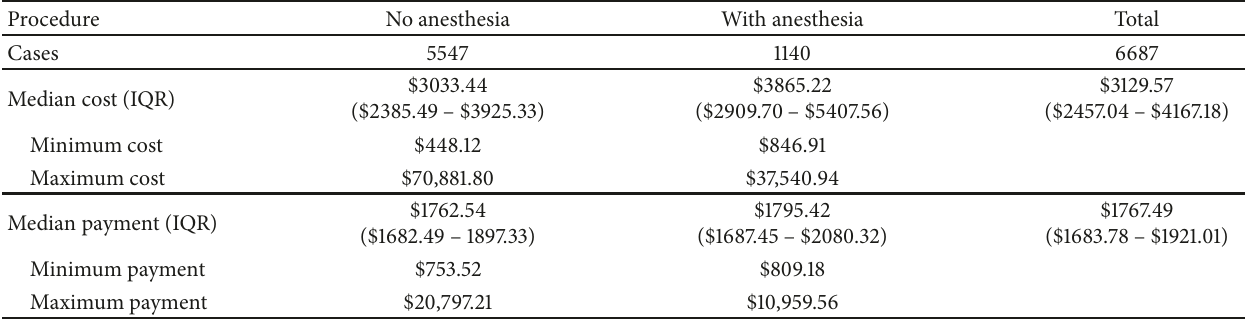
Table 4: Cost and payment data extracted from the 2016 Medicare outpatient hospital standard analytical file for the common procedural terminology code 37193 (IVC filter removal)